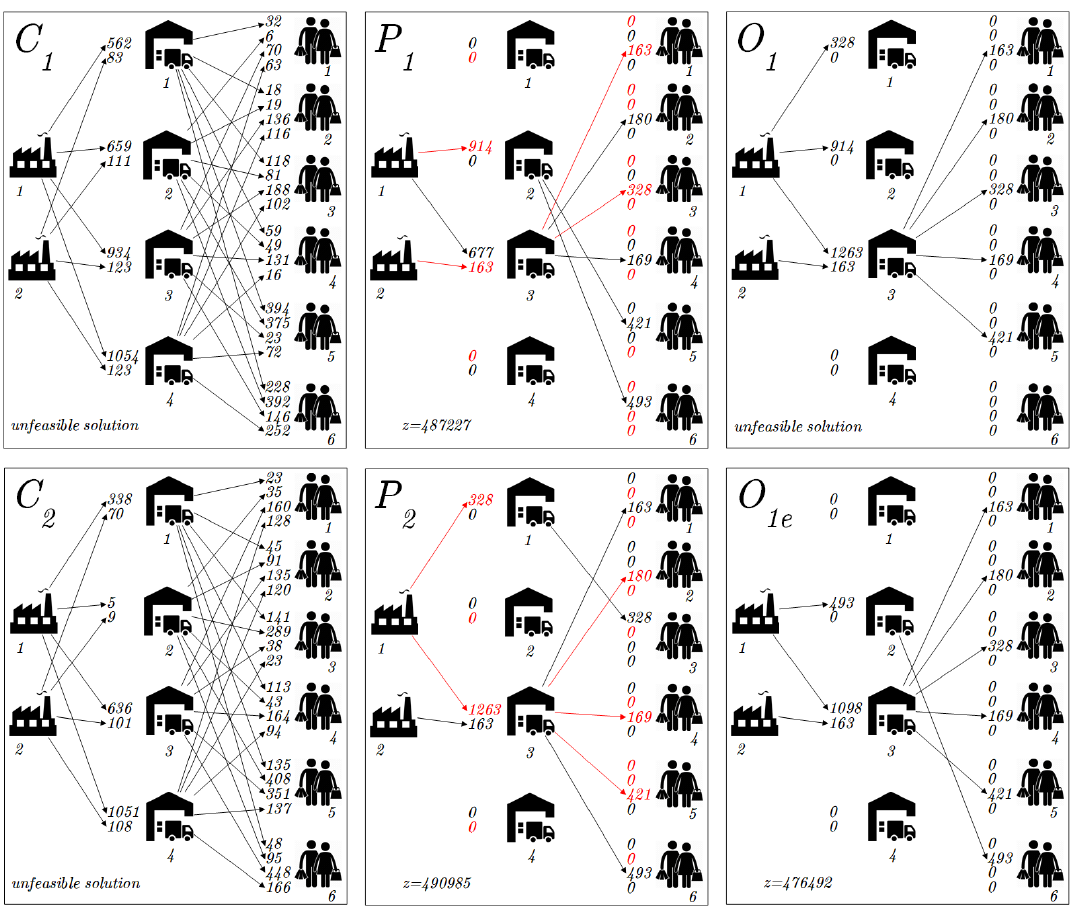
Figure 6. The crossover